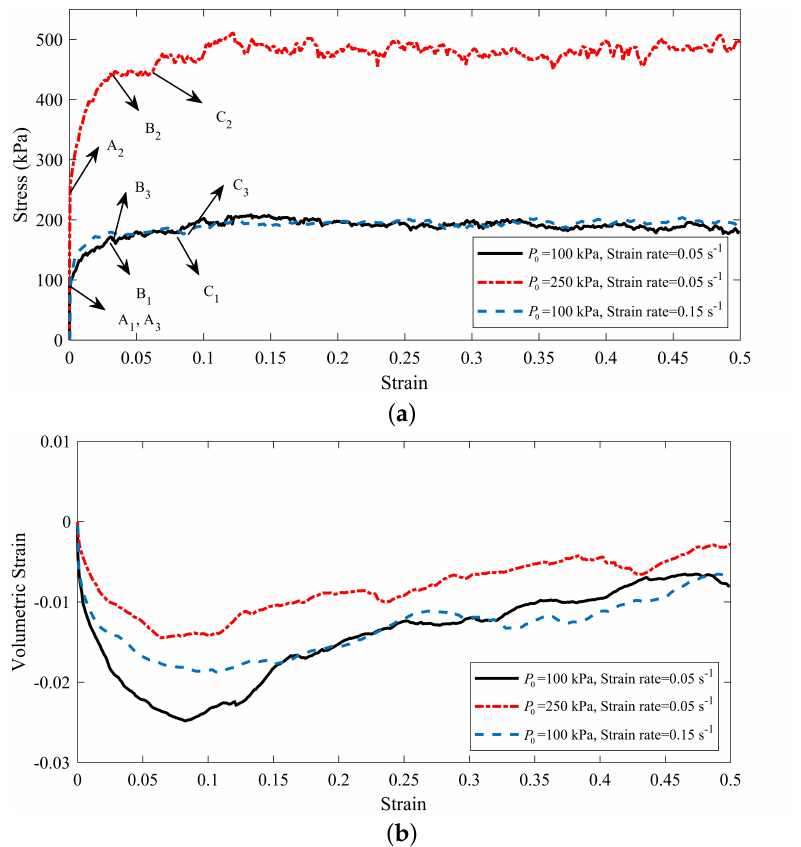
Figure 13. ( a ) Theshear stress behavior and ( b ) the volumetric strain behavior of specimens S 1 , S 2 , and S 3